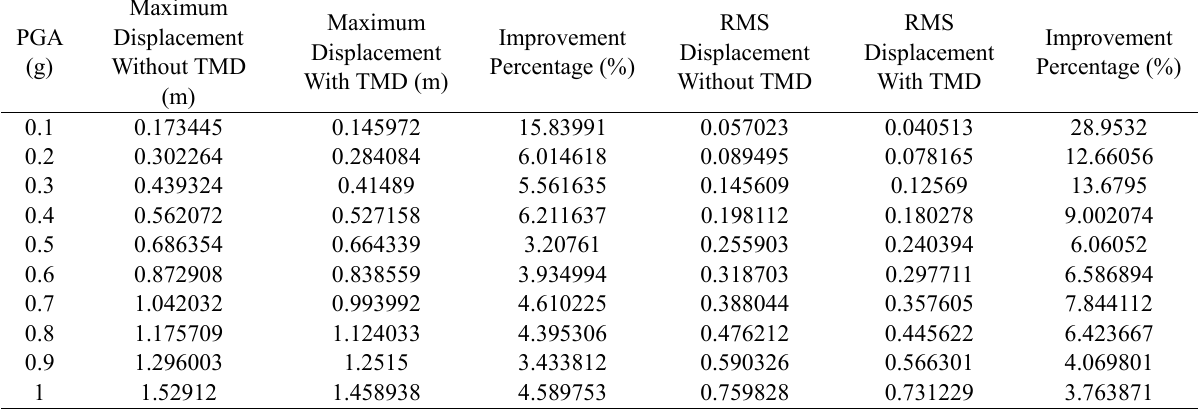
Average Value of the Max Displacement and RMS of the Roof of an Irregular Mass Structure, on the first floor, based on Far-Field Earthquakes.